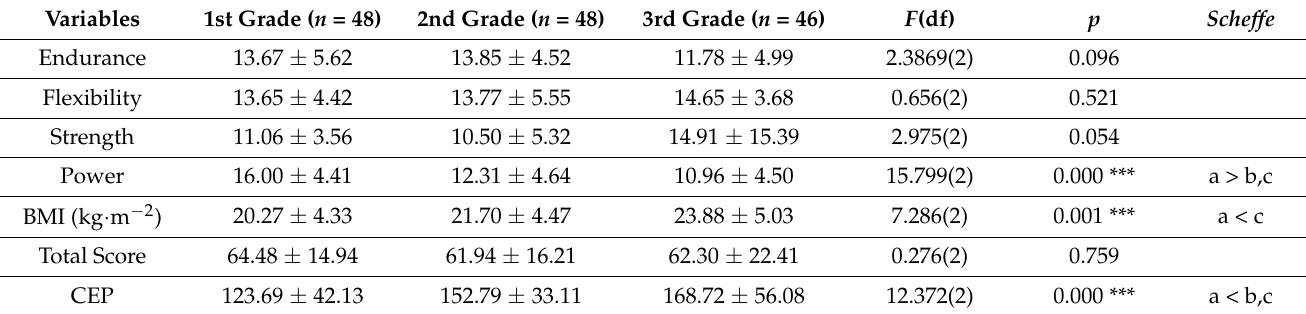
Table 3. Comparison of PF levels by grade (Mean ± SD).